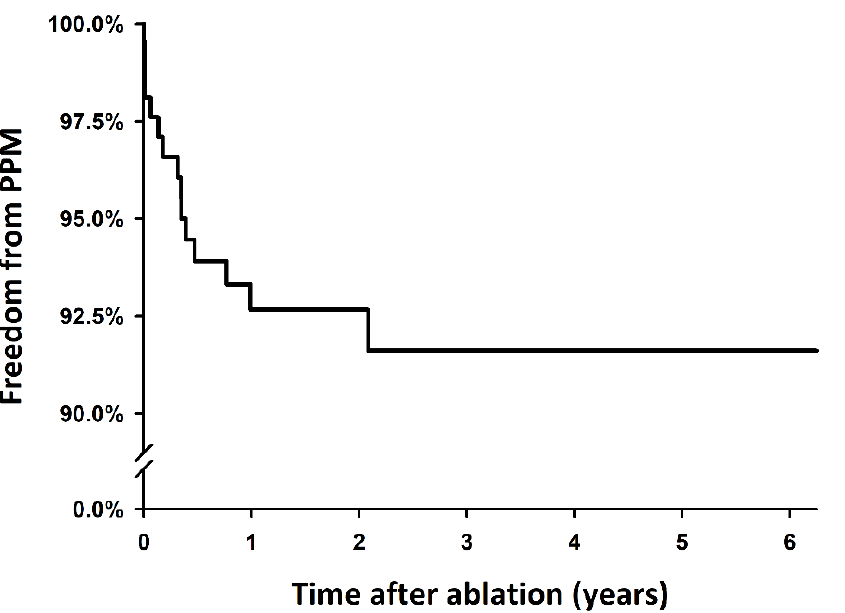
Figure 2. Kaplan–Meier estimates for the PPM implantation after ablation for persistent AFL. After ablation for persistent AFL, the cumulative incidence of delayed SND requiring a PPM implantation increased for several months, almost reaching a plateau after 1 year. AFL: atrial flutter; PPM: permanent pacemaker; SND: sinus node dysfunction.